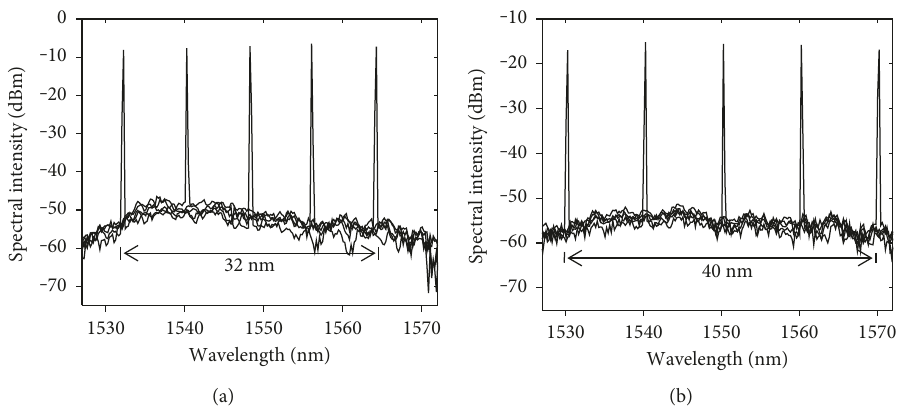
Figure 8: Tunable output laser spectra. (a) Configuration 1. (b) Configuration 2.